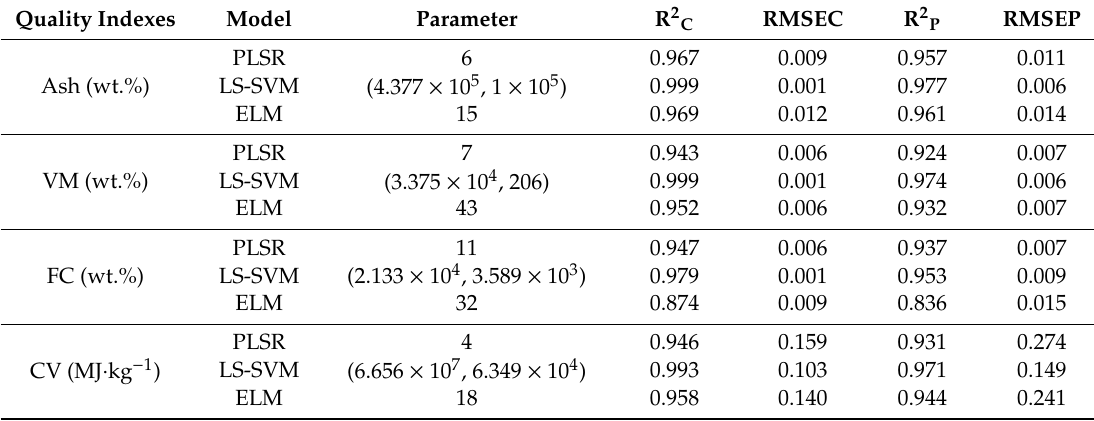
Table 3. Prediction results of chemometric models.